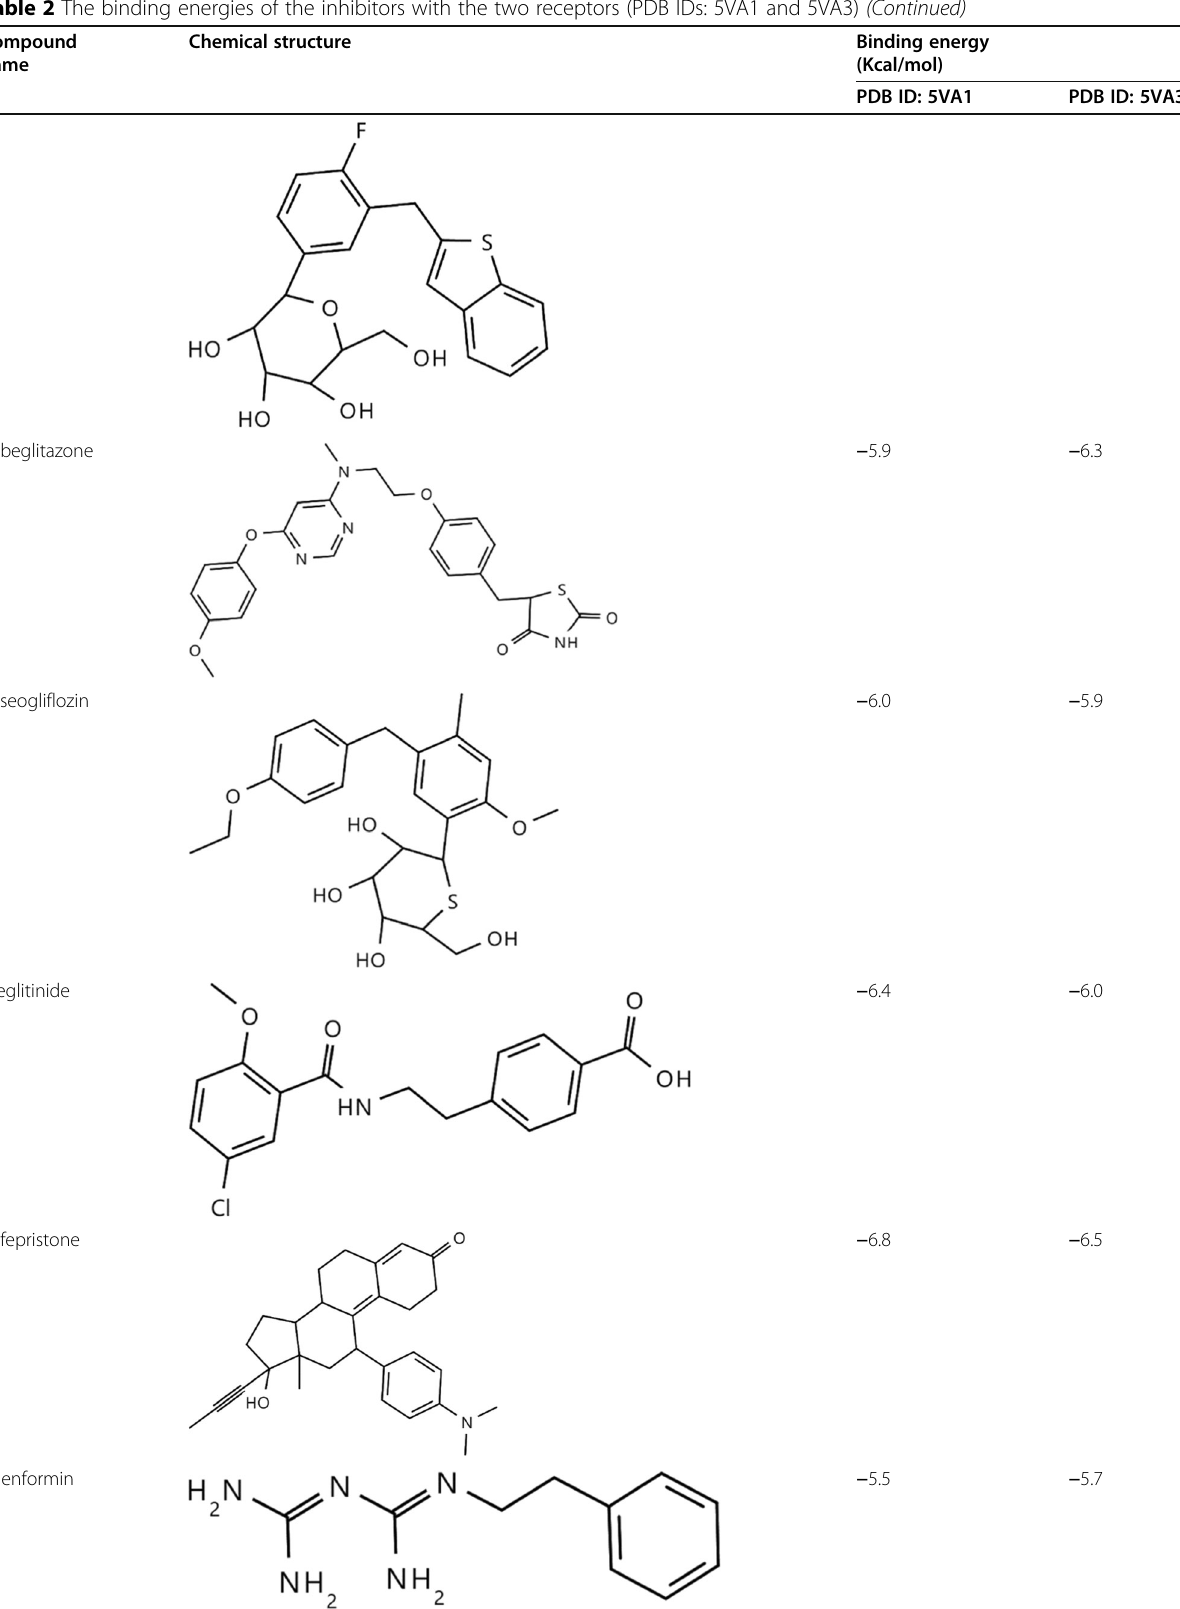
Table 2 The binding energies of the inhibitors with the two receptors (PDB IDs: 5VA1 and 5VA3)